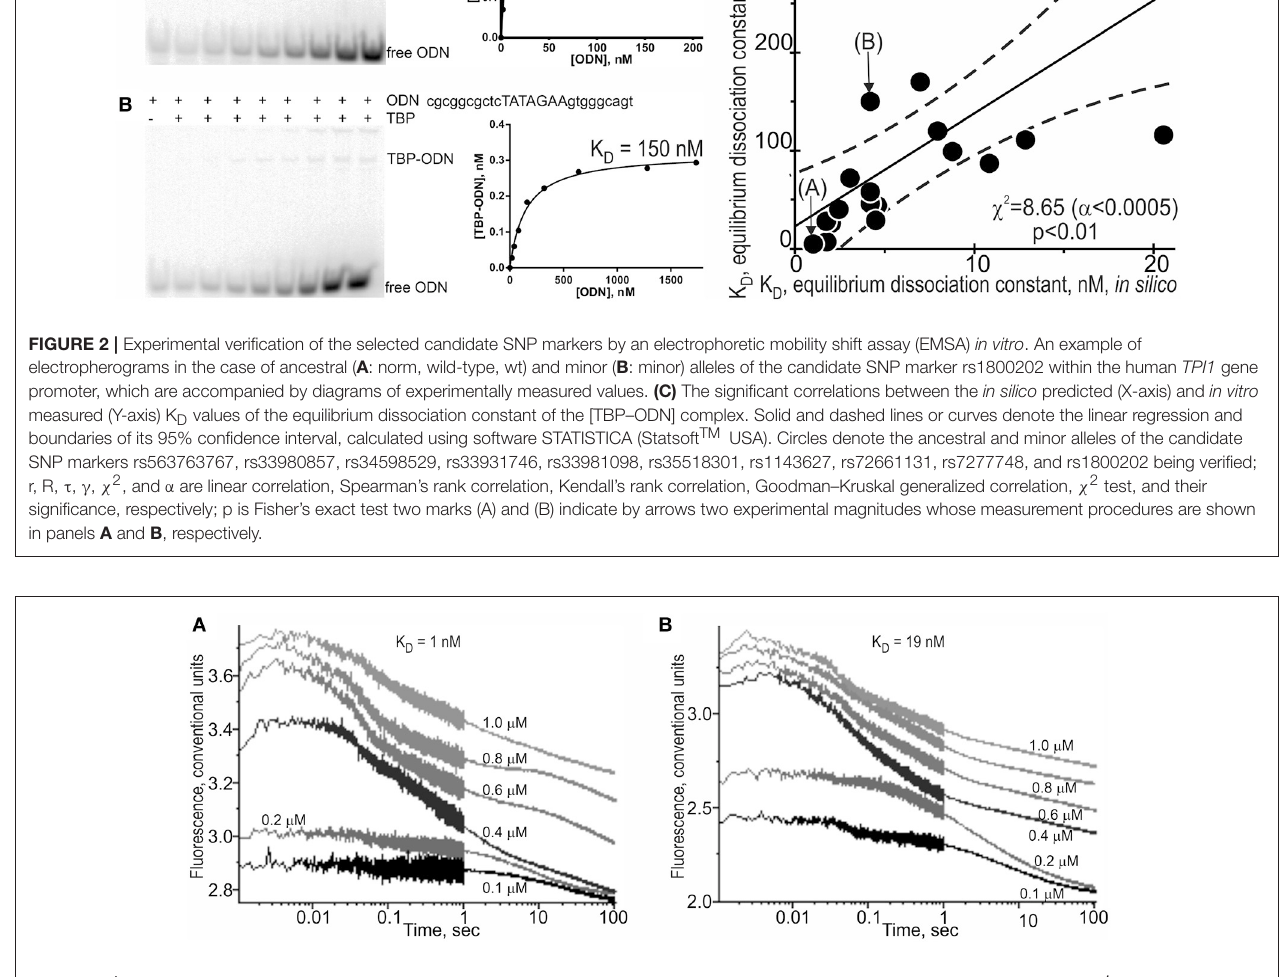
FIGURE 3 | The kinetics of binding to and bending of the ODN identical to the selected SNP marker rs1800202. (A) The ancestral allele, ODN 5 ′ -cgcggcgctcTATAT AAgtgggcagt-3 ′ . (B) The minor allele, ODN 5 ′ -cgcggcgctcTATAgAAgtgggcagt-3 ′ . ODN concentration was 0.1 µ M. TBP concentration was varied between 0.1 and 1.0 µ M as indicated near the corresponding curve of the time series. K D values, (A) 1 nM and (B) 19 nM, were obtained as the output of the Dynafit software (Biokin, USA) after the corresponding time-series data were inputted into this